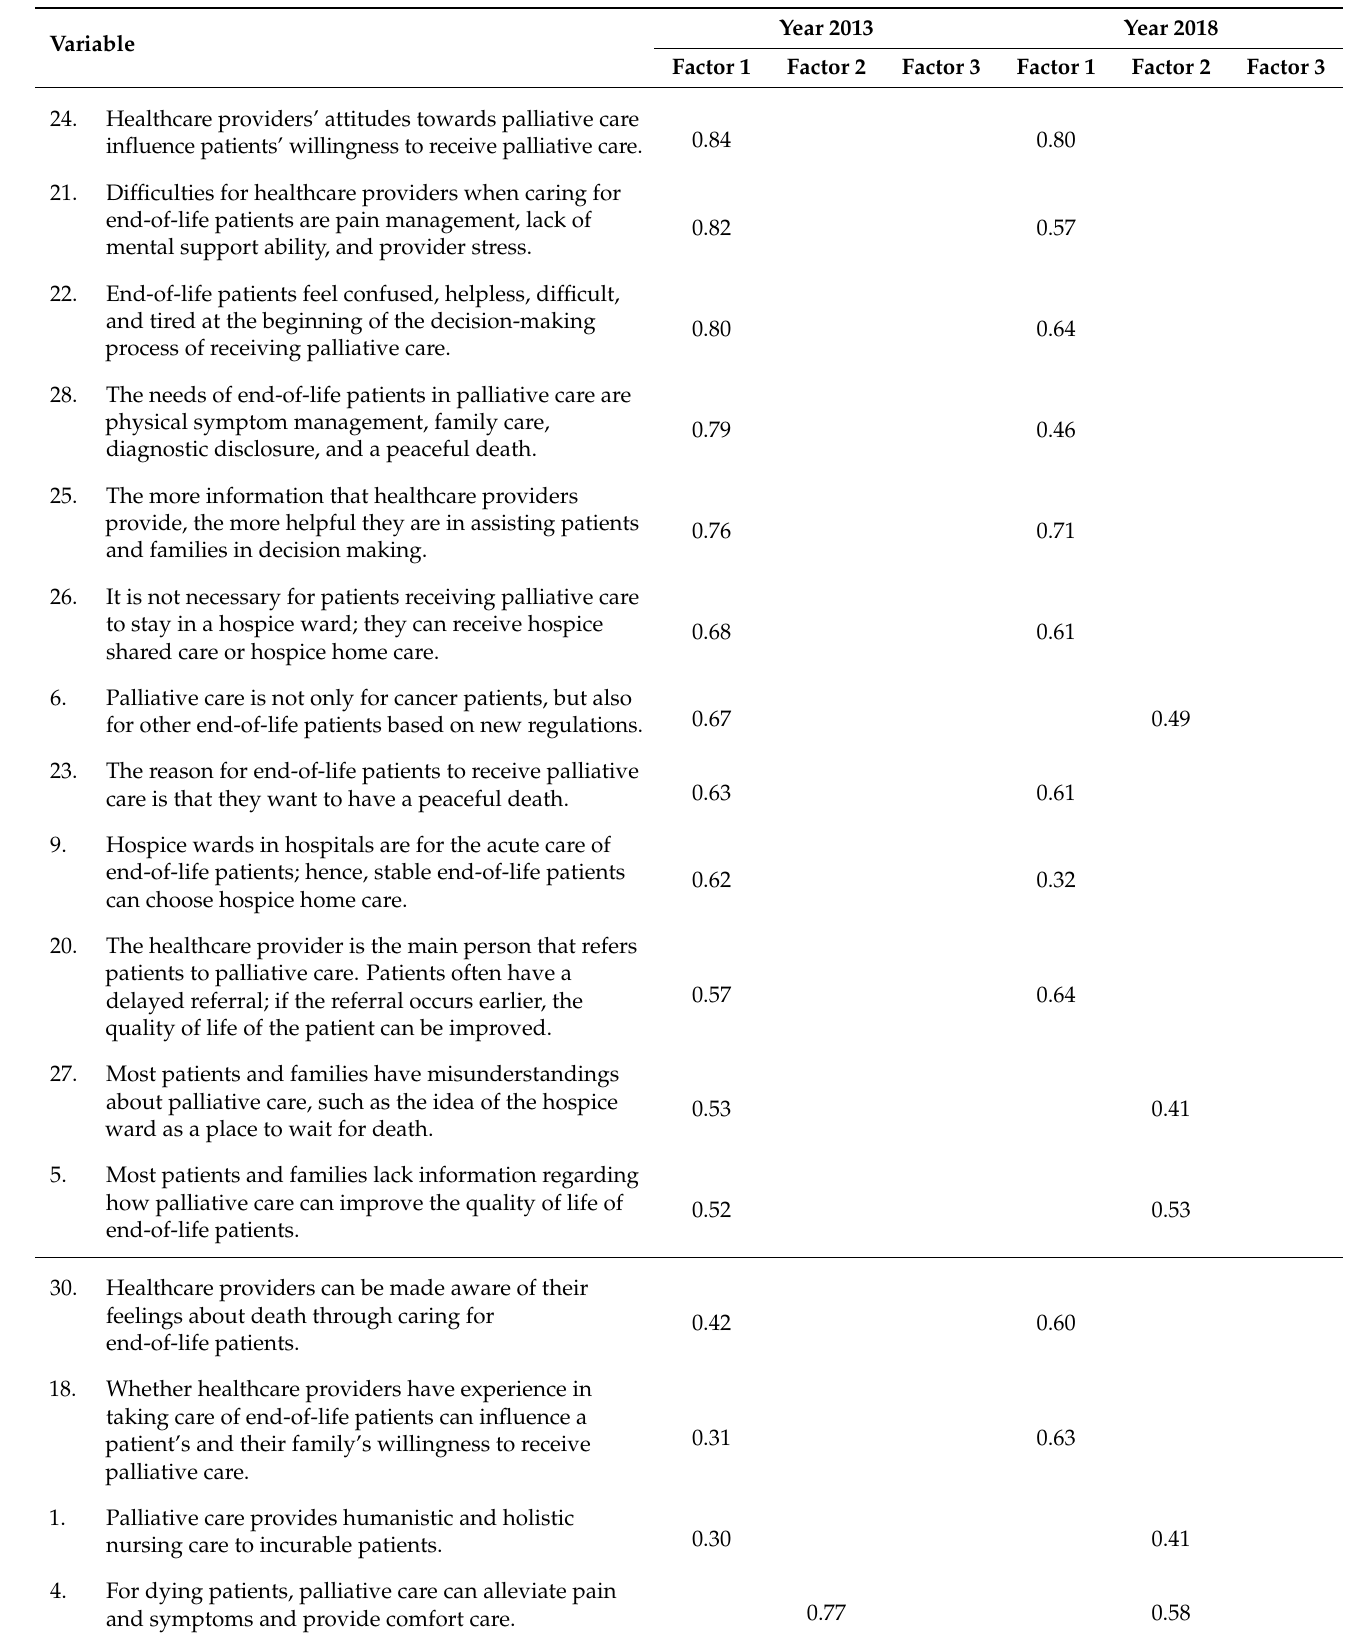
Table 4. Factor loadings for items of the scale of knowledge of palliative care in 2013 and